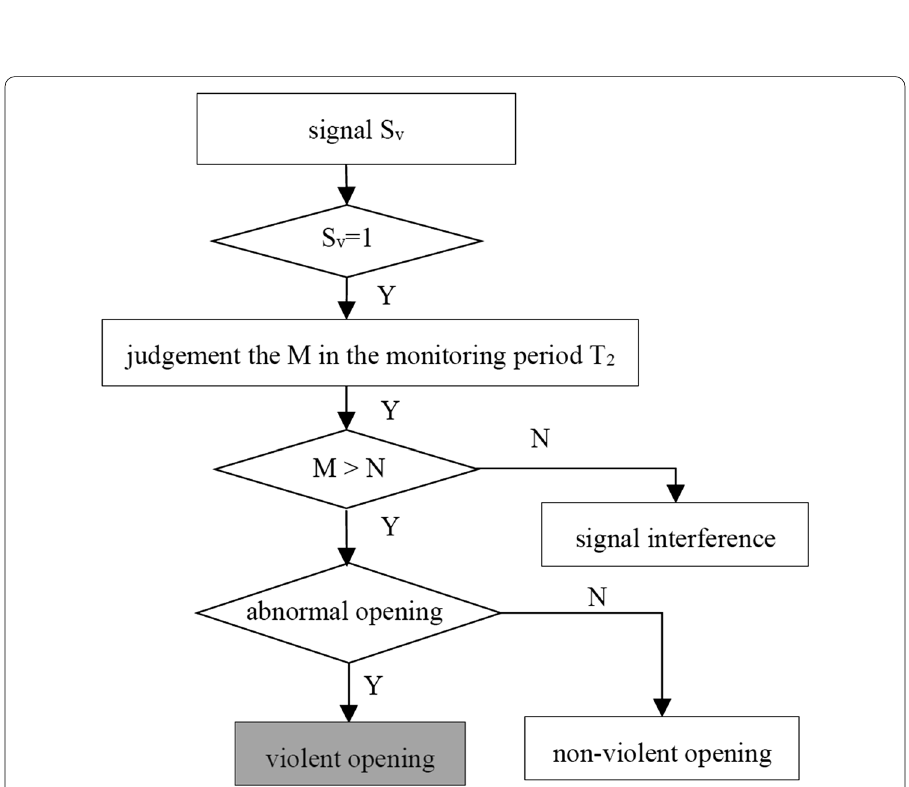
Fig. 5 The judgment method of violent opening event of outer manhole